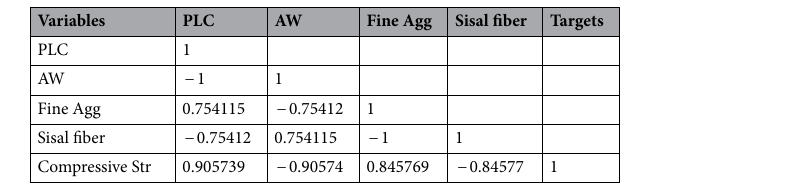
Figure 10. Output data.